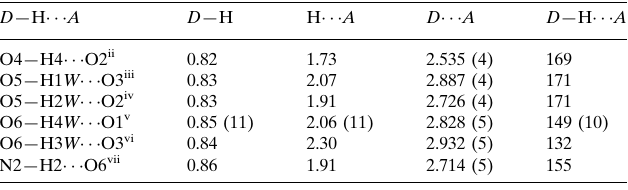
Hydrogen-bond geometry (A˚ , (cid:3)